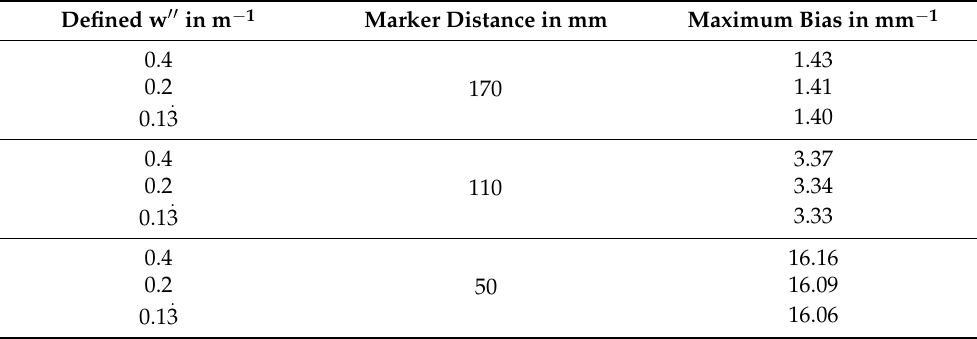
Figure A2. Schematic drawing of the maximum theoretically possible systematic bias of the calibra- tion profile in terms of curvature (w (cid:48)(cid:48) ) calculation. Table A1. Maximum constructed bias based on the tolerance specifications in Figure A1 and the schematic drawing of Figure